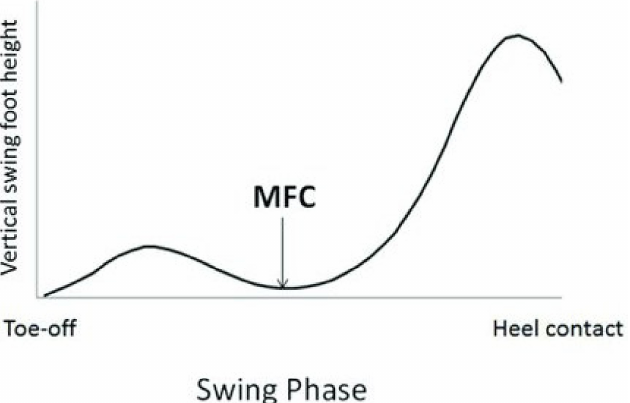
Figure 1. Vertical displacement of a point on the swing foot near the great toe over one stride. The minimum foot clearance (MFC) is defined by the local minima of the swing foot following toe-off. (Figure by Nagano et al. [9] licensed under CC by